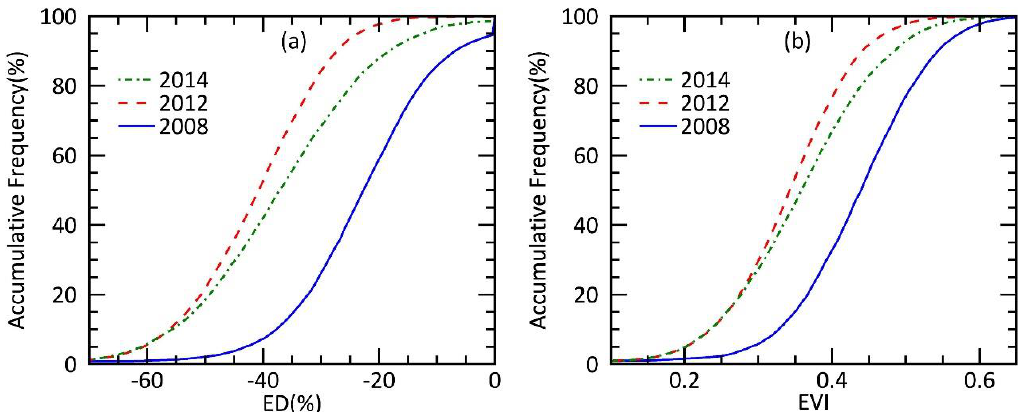
Figure 4. EVI Deficit (ED) ( a ) and enhanced vegetation index (EVI) ( b ) in the recovery areas, affected by drought during 2009–2013 and with improved water condition in 2014, before (blue, 2008), during (red, 2012), and after drought stress (green, 2014).